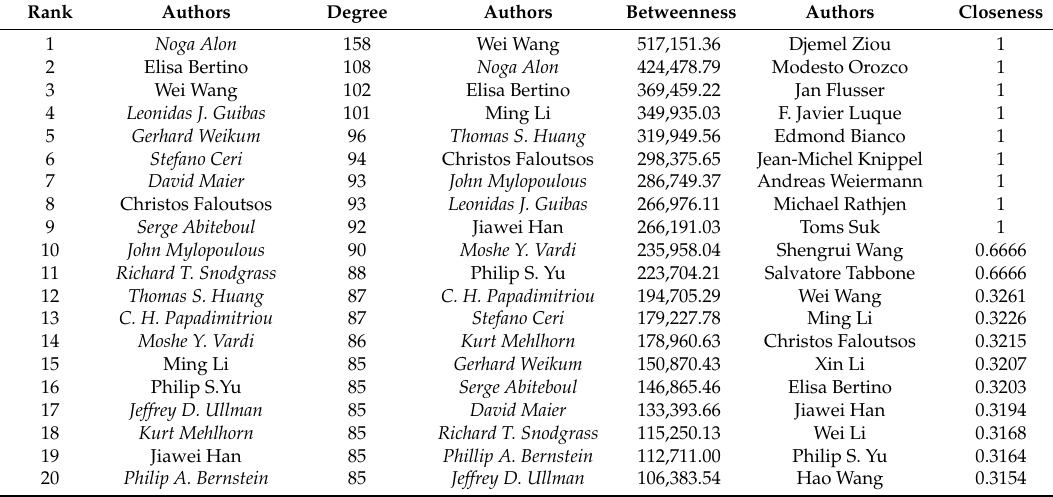
Table 3. Author rank according to centrality